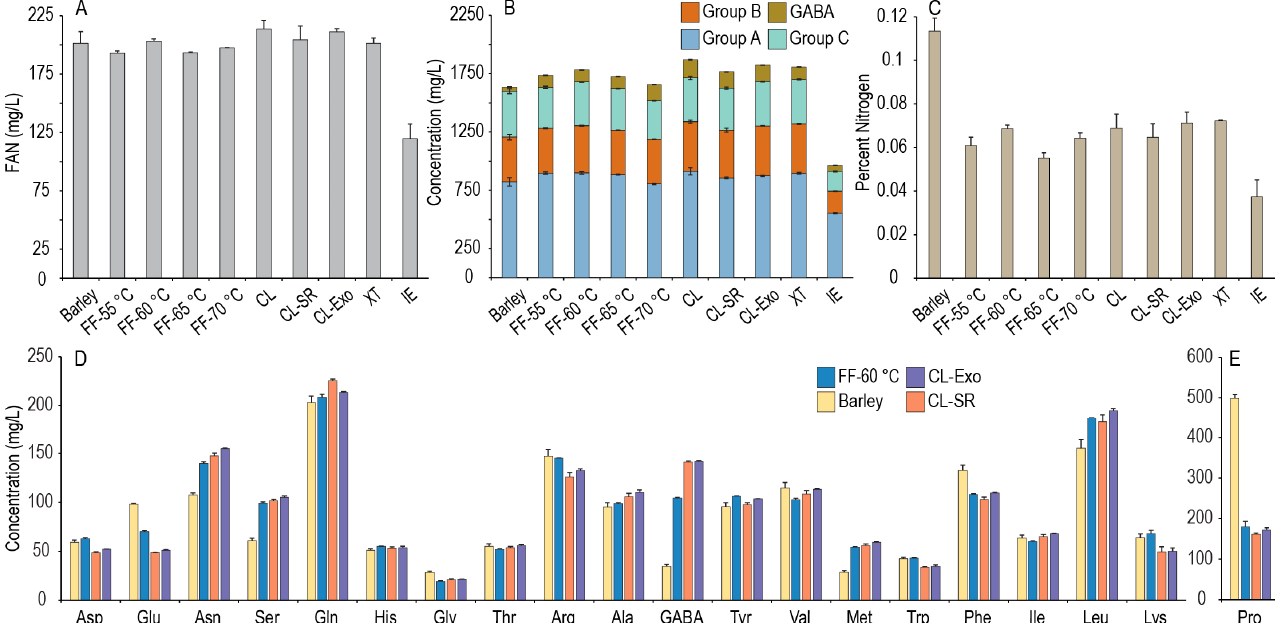
Figure 4. FAN measurements ( A ); sum of usable amino acids by utilization group and GABA ( B ); soluble nitrogen measurements ( C ); and select amino acid profiles ( D ) comparing the barley infusion mash samples and the endpoints of the time-course millet mash samples. XT and IE samples refer to the millet-XT and millet-IE samples described in Section 2.3, and all samples are from worts at a final liquor-to-grist ratio of 6:1 and ( E ) comparing proline levels from these worts.